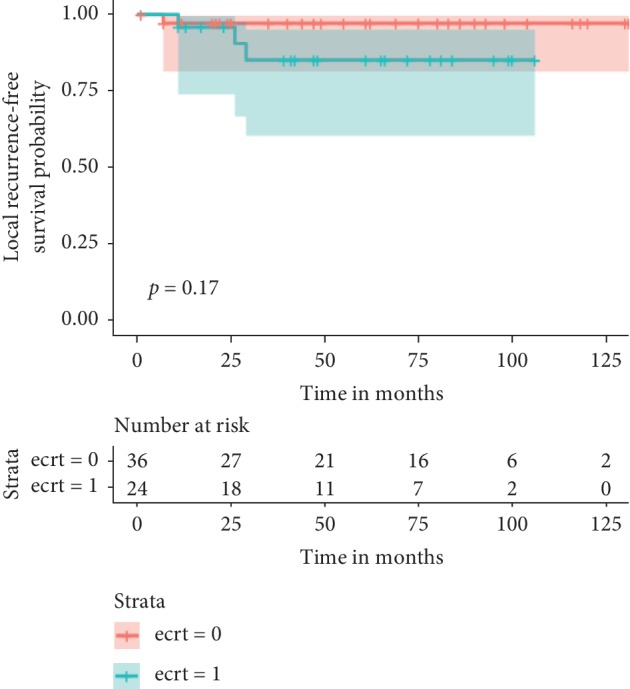
Kaplan‐Meier curves showing local recurrence-free survival stratified by use of reimplantation. Green line with reimplantation of tumor bone and the red without. Time is in months.